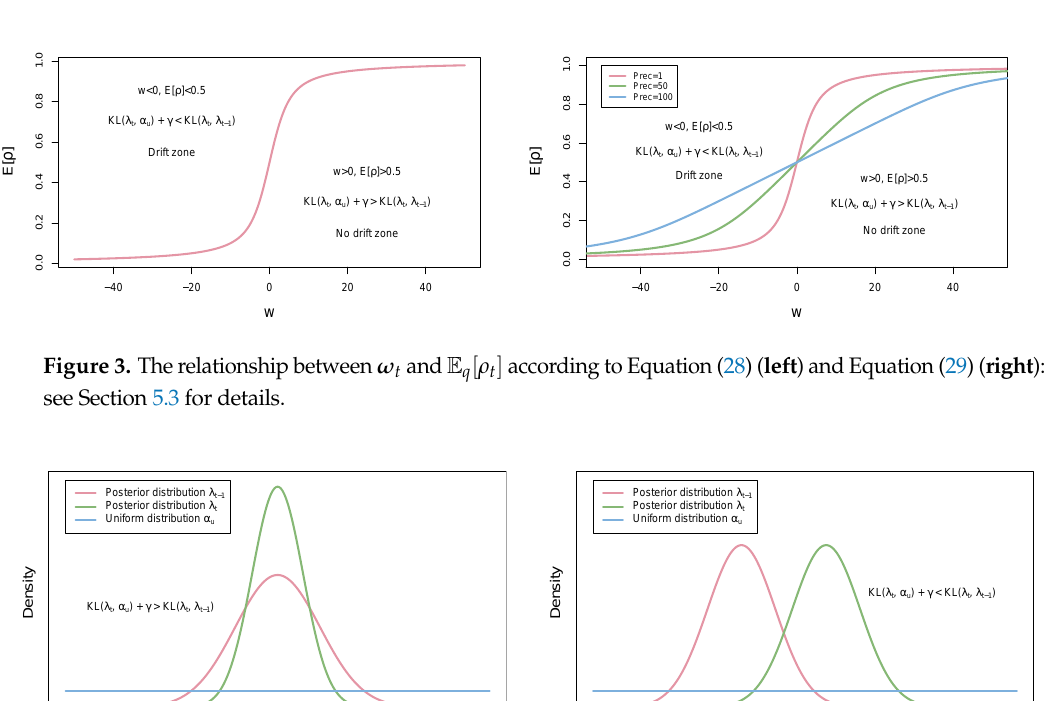
Figure 4. Example with Gaussian posterior distribution are shown. Two possible situations: no concept drift ( left ) when λ t is closer to λ t − 1 than to α u (in terms of KL divergence); otherwise ( right ), there is concept drift. See Section 5.3 for